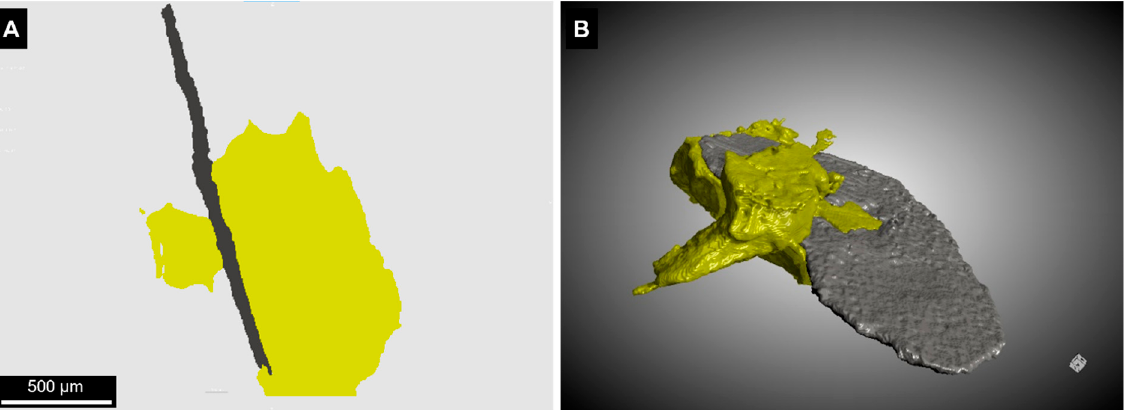
Figure 11. Jumbo-sized flake associated with an iron sulfide mineral in 2D ( A ) and 3D ( B ). The CT volume slice ( A ) shows that the graphite flake is attached to the sulfide mineral. By contrast, the rendered 3D image ( B ) reveals that the sulfide mineral is intergrown with the graphite flake. The longest axis of the flake is 1690 µm.